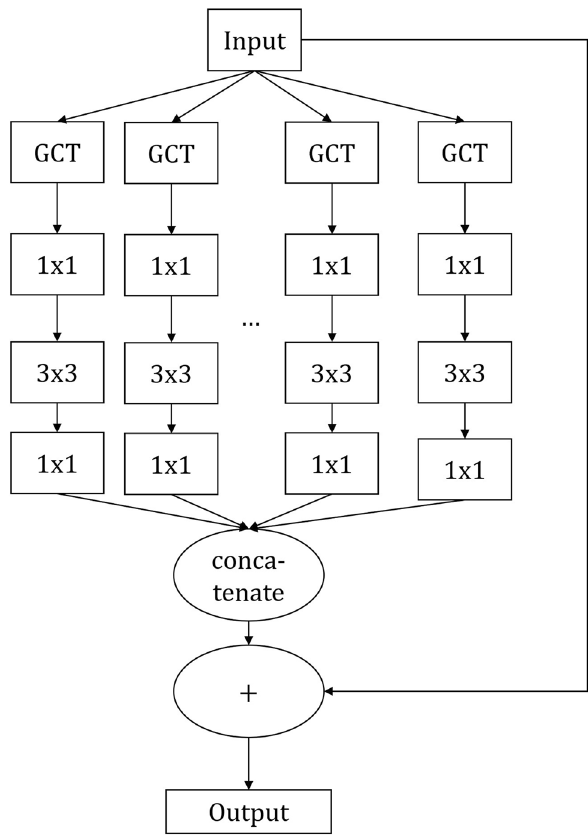
Fig. 3 The multipath network